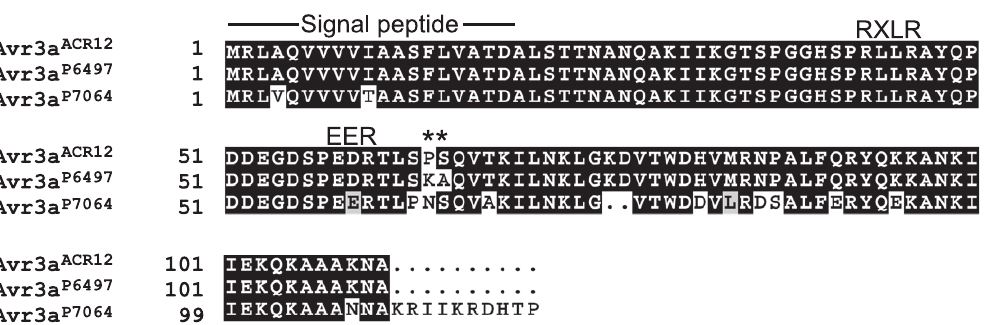
Figure 2. Predicted amino acid sequences of Avr3a alleles from three strains of P.sojae . The position of the predicted signal peptide and the RXLR and EER host-targeting sequences are shown. The deduced Avr3a protein sequence in P. sojae strains P6497 and ACR12 differs by two amino acids, as indicted by the asterisks. The Avr3a genes from strains P6497 and ACR12 are transcribed whereas no transcripts can be detected for Avr3a from P7064.